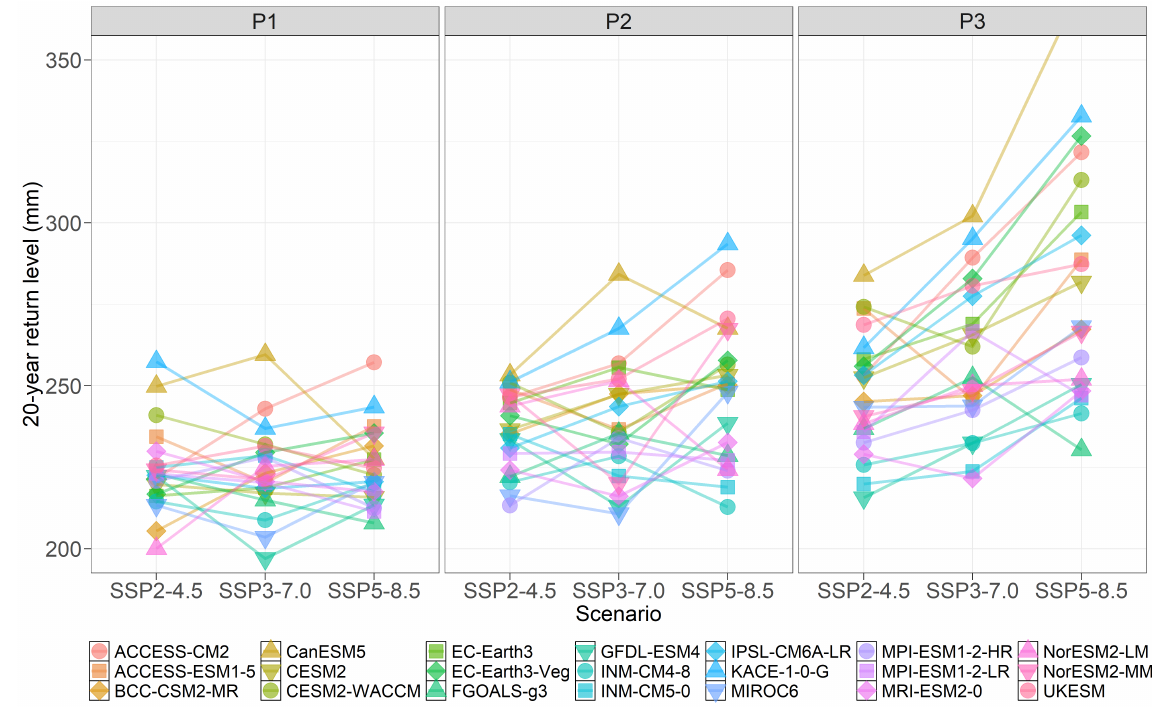
Figure 12. Interaction plots of the 20-year return levels from the 21 CMIP6 models for three SSP scenarios for each period (P1, P2, and P3).